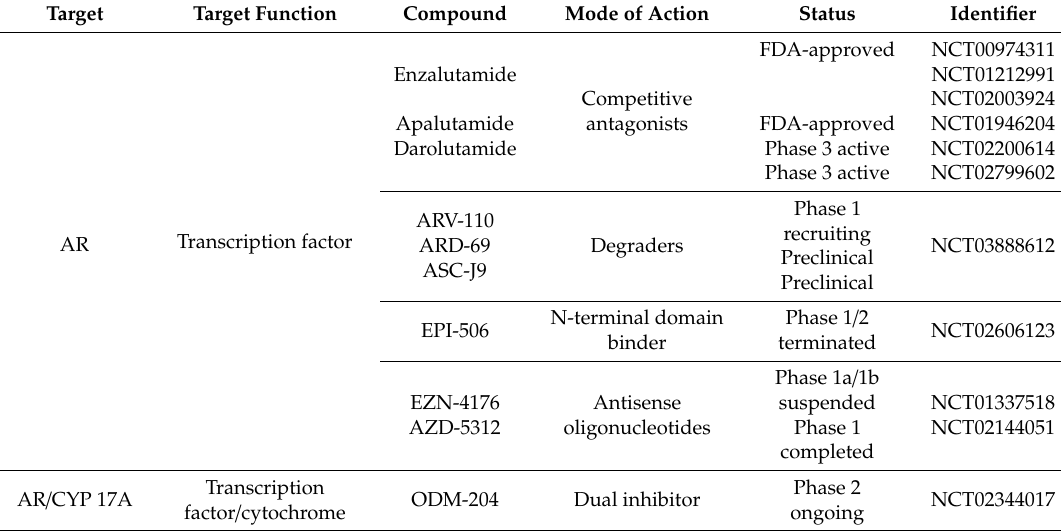
Table 1. Prostate cancer targets involved in gene regulation and selected inhibitors. Only the most advanced clinical studies are